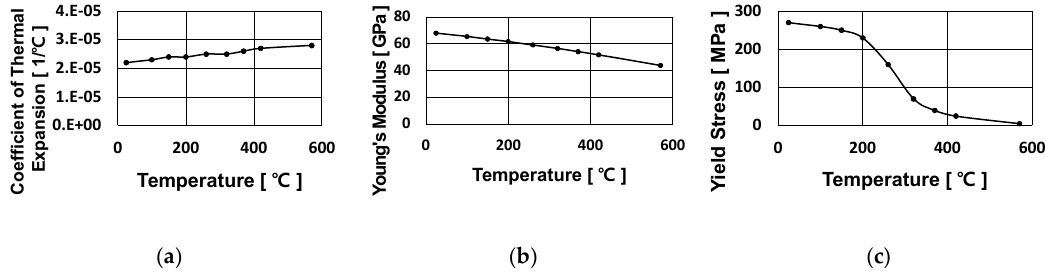
Figure 17. AL6063-T5 material properties required for thermal elasto-plastic analysis: ( a ) Coefficient of thermal expansion; ( b ) Young’s modulus; ( c ) yield stress.